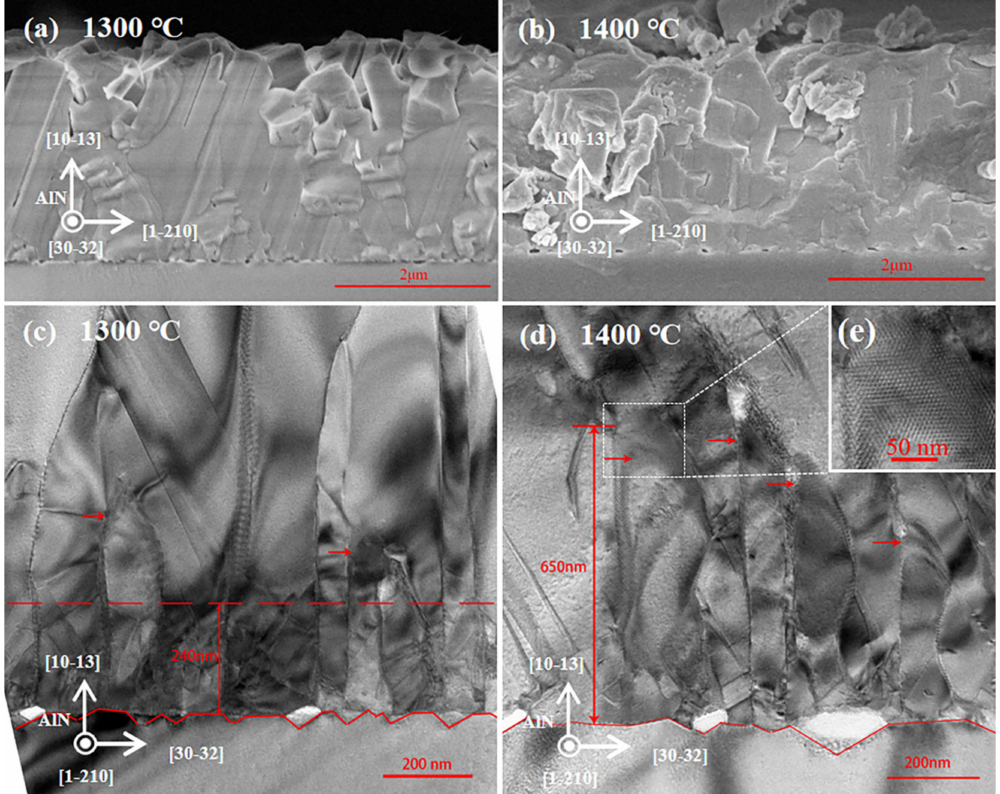
for samples ( a ) S4 and ( b ) S5. 1210 ] for samples ( c ) S4 and ( d ) S5. 3032 ]